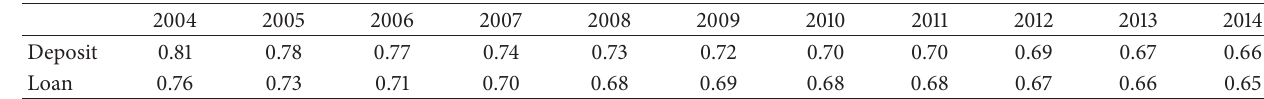
Table 1: Market shares of sample